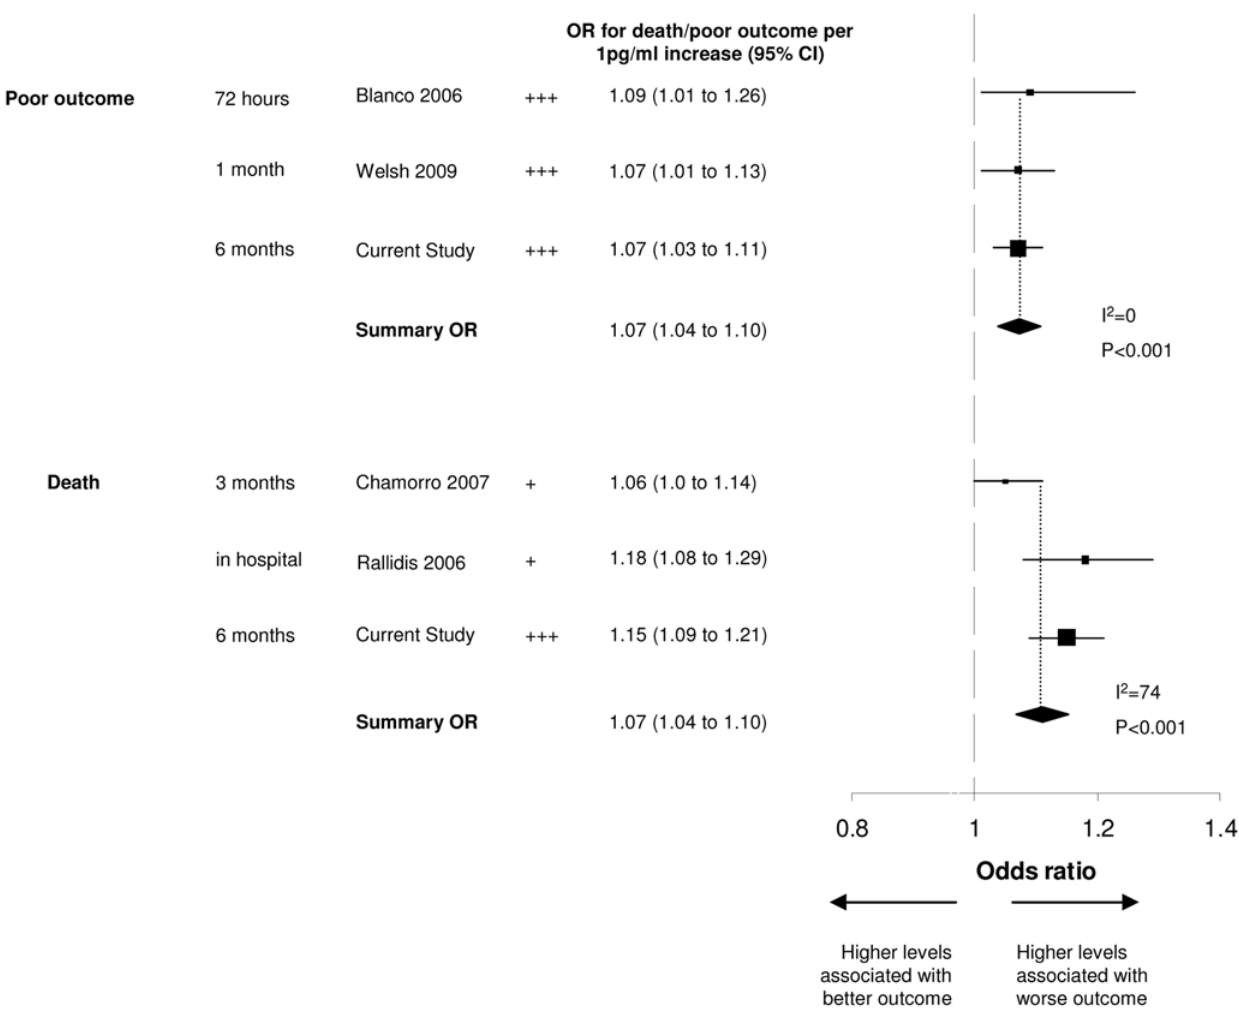
Figure 4. Systematic review and meta-analysis of studies of IL-6 with available data. OR for death or poor outcome is presented per unit increase in marker levels. Sizes of squares are proportional to the number of patients in each study. Summary estimates are calculated by fixed effects meta-analysis. The p values show statistical significance of summary estimate of effect, and I 2 is reported as a measure of heterogeneity between studies used to calculate the summary OR. + =adjusted for age or stroke severity; ++ =adjusted for age and stroke severity; +++ =adjusted for age, stroke severity, and other factors.